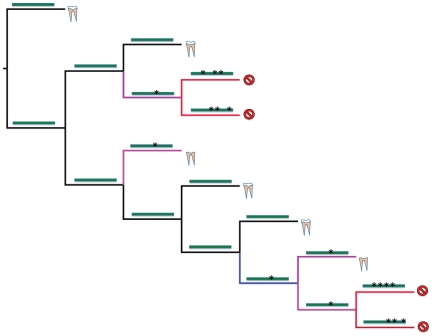
Hypothetical tree showing relationships of four toothed mammals (yellow and white components represent a full tooth), three enamelless tooth mammals (lack of white element represents loss of enamel), and four edentulous (toothless) mammals (slashed circle).Four branch types are then placed onto the tree using character reconstruction of the tooth anatomy and reconstruction of the ENAM gene. Functional branches (black) are those that have terminal nodes with a species with enamel or an internal node that was reconstructed as having had enamel. By definition, these branches will have genes on them that are reconstructed as having no stop codons or frameshifts. All other branches that are reconstructed as not having enamel in teeth can be premutation, mixed, or pseudogenes. In addition, any internal node that was reconstructed as not having enamel can be premutation, mixed, or pseudogenic. The presence or absence of stop codons or frameshifts in the ENAM gene was then used to establish the reconstructed state of these branches. In the figure, an uninterrupted gene has no asterisks on it while a gene with stop codons or frameshifts shows an asterisk. These branches are categorized as pre-mutation (blue) if the ENAM gene on the branch had no stop codons or frameshifts. A mixed branch (purple) contains the first detected occurrence of a frameshift mutation or stop codon in ENAM. And finally, a branch is a pseudogene branch (red) if it postdates the first occurrence of the frameshift or stop codon.